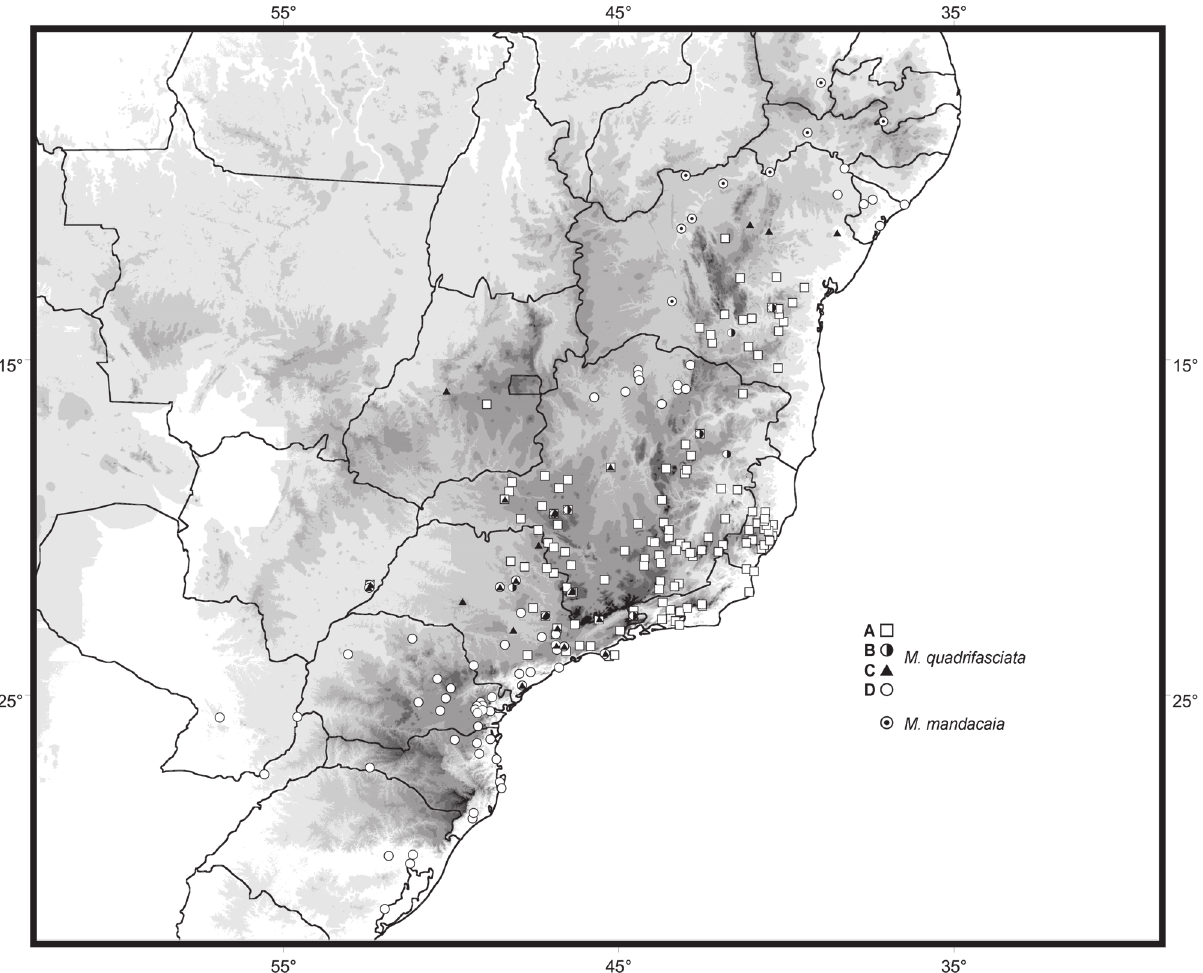
Figure 5. Distribution map for M. quadrifasciata and M. mandacaia . The records of the different patterns of tergal stripes (class A-D) in M. quadrifasciata are discriminated in the map (see text for characterization of the pattern classes). The different gray tones in the map are based on digital reconstruction of the relief, where the darkest tones indicate higher